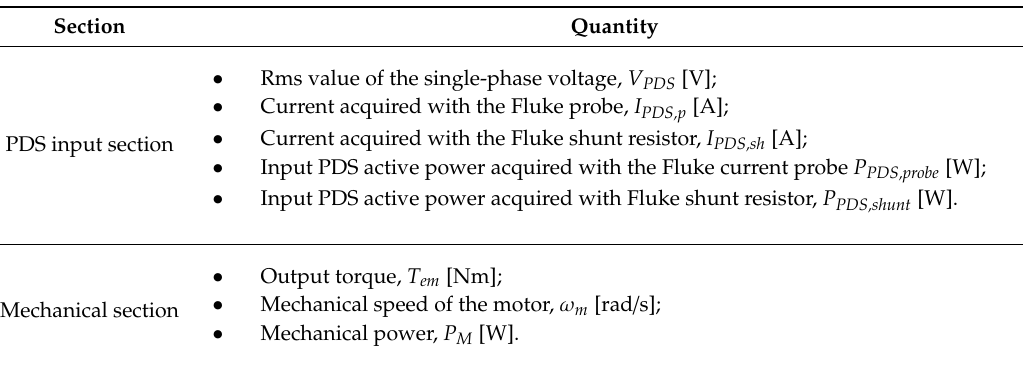
Table 7. Measurement arrays for the PDS Section.